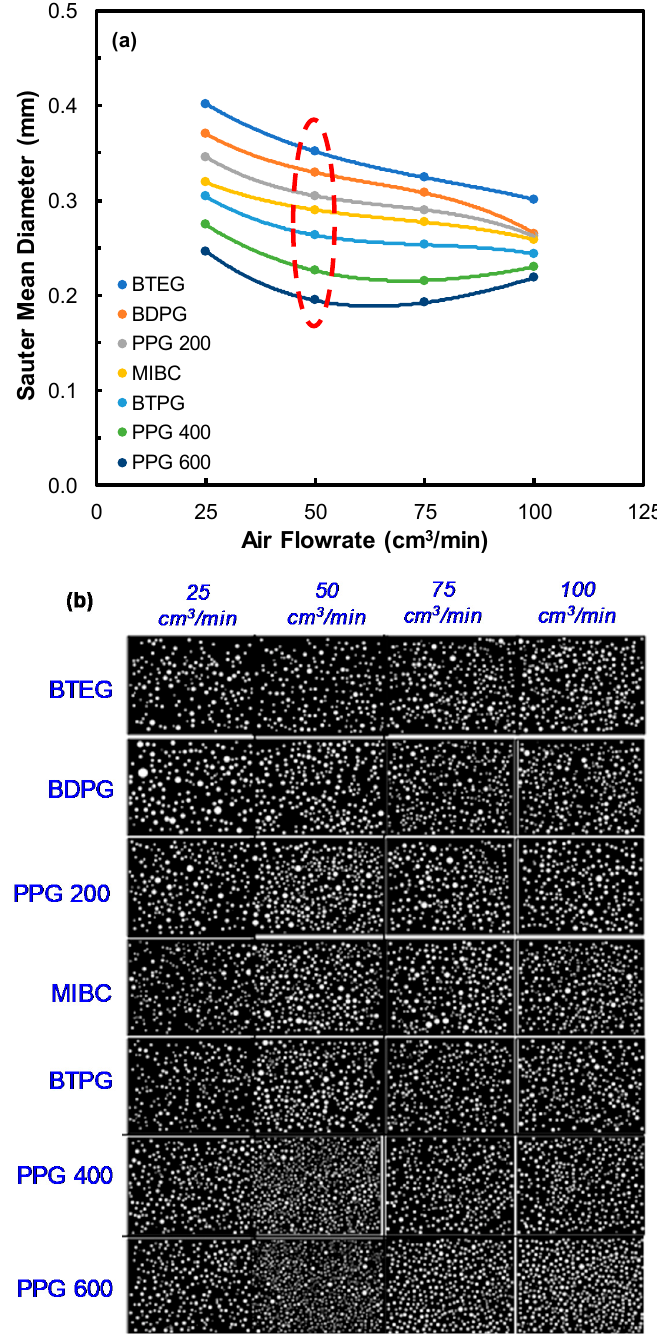
Figure 4 . ( a ) Effect of air flowrate on the SMD of bubbles (Frit pore size: 10–16 μ m; frother concen- tration: 50 ppm), ( b ) Images of bubbles as a function of air